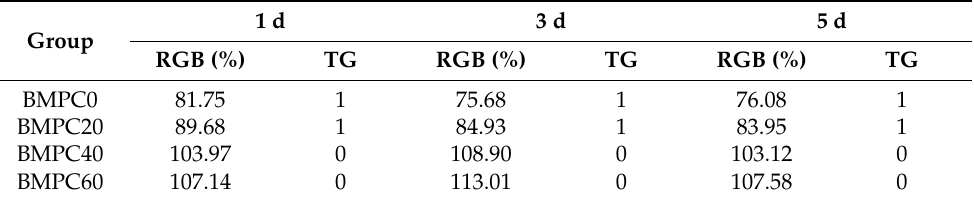
Table 3. The relative growth rate (RGB) and toxicity grade (TG) of BMPC samples.